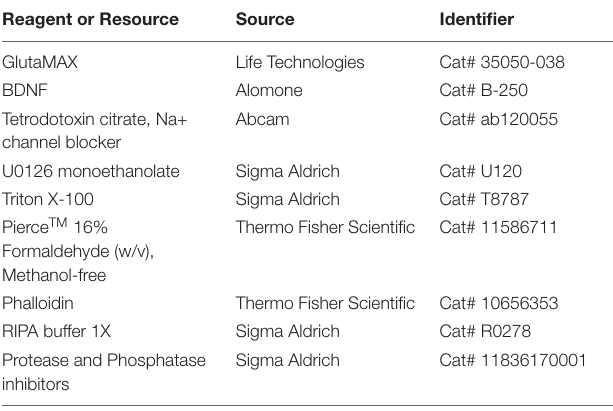
TABLE 1 | Key resources